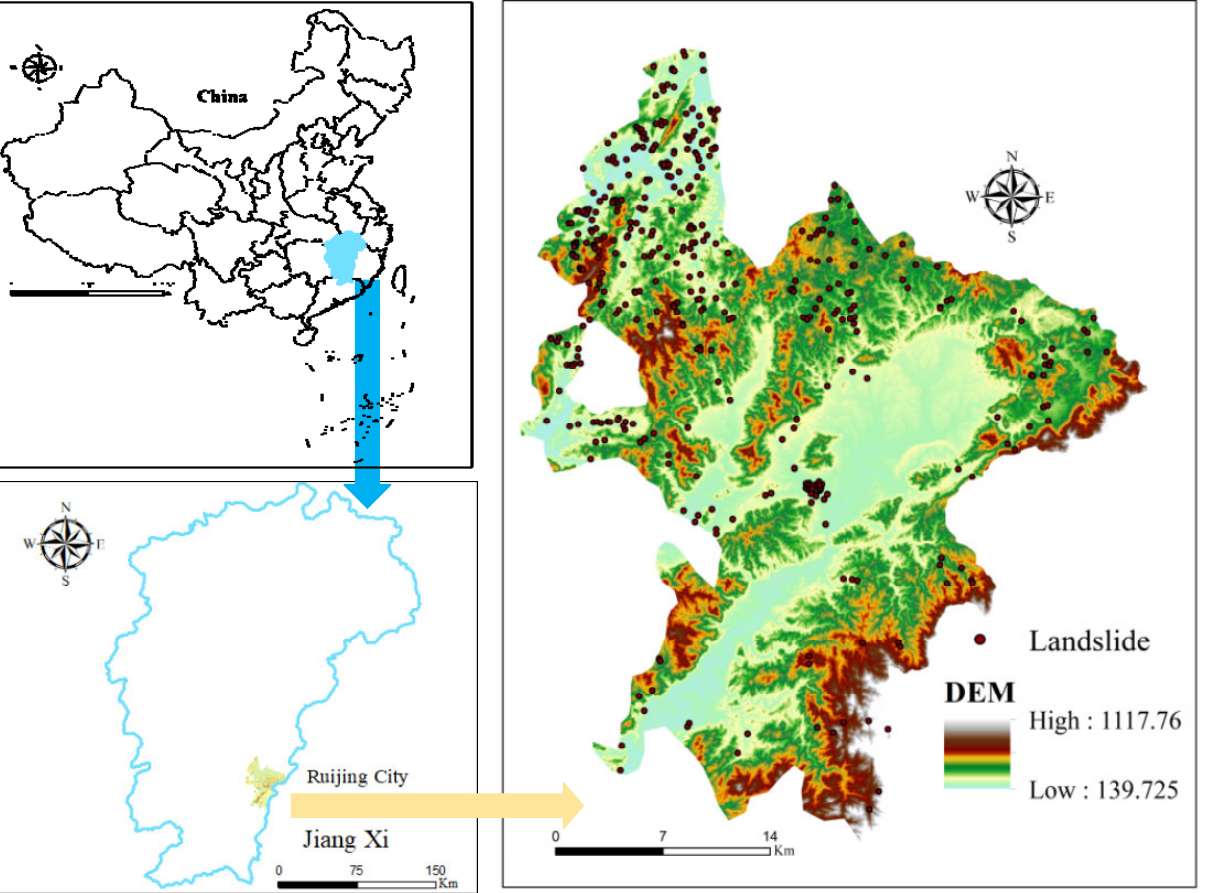
Figure 3. Location of the study area and landslide inventory